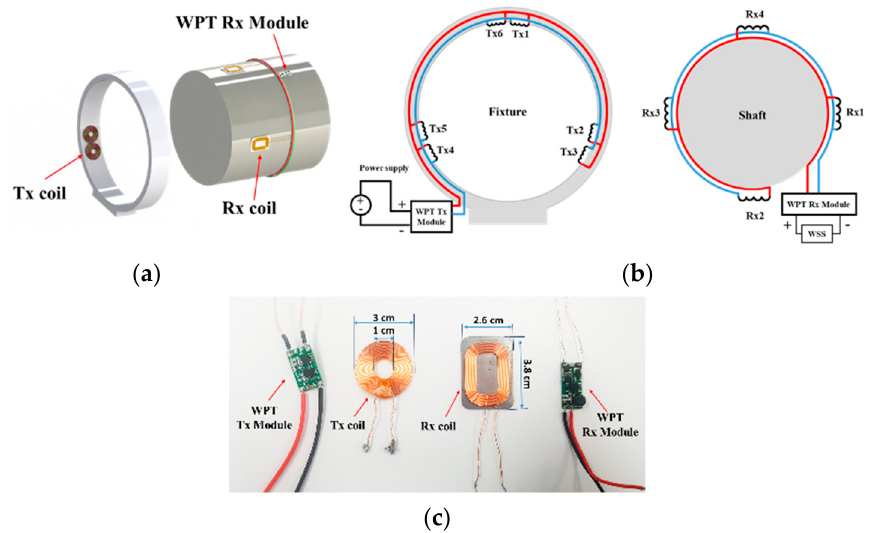
Figure 2. A 3-D design of the I-WPT module ( a ), equivalent circuits of the I-WPT module ( b ), and photos of the Tx and Rx coils and each module ( c ).